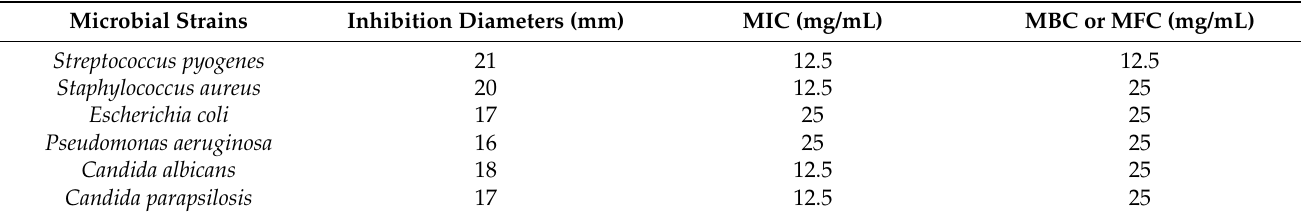
Table 2. Antimicrobial activity of Pg-AgNPs_S2.